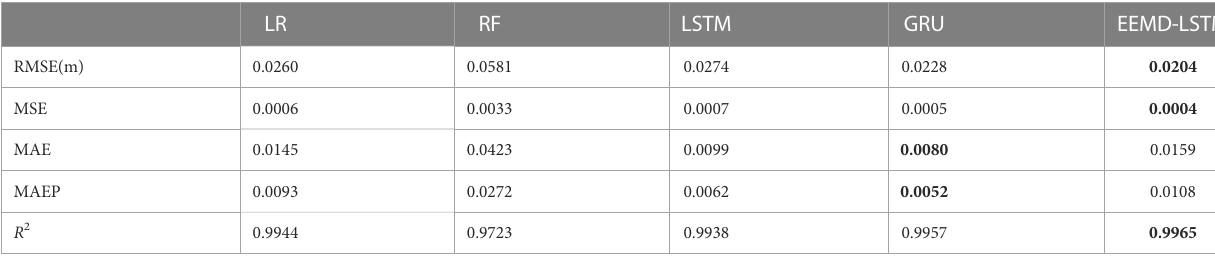
Bold values in the table indicate optimal results.